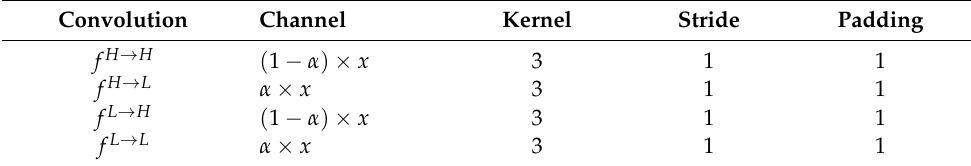
Table 2. The details of different f ( X ; W )